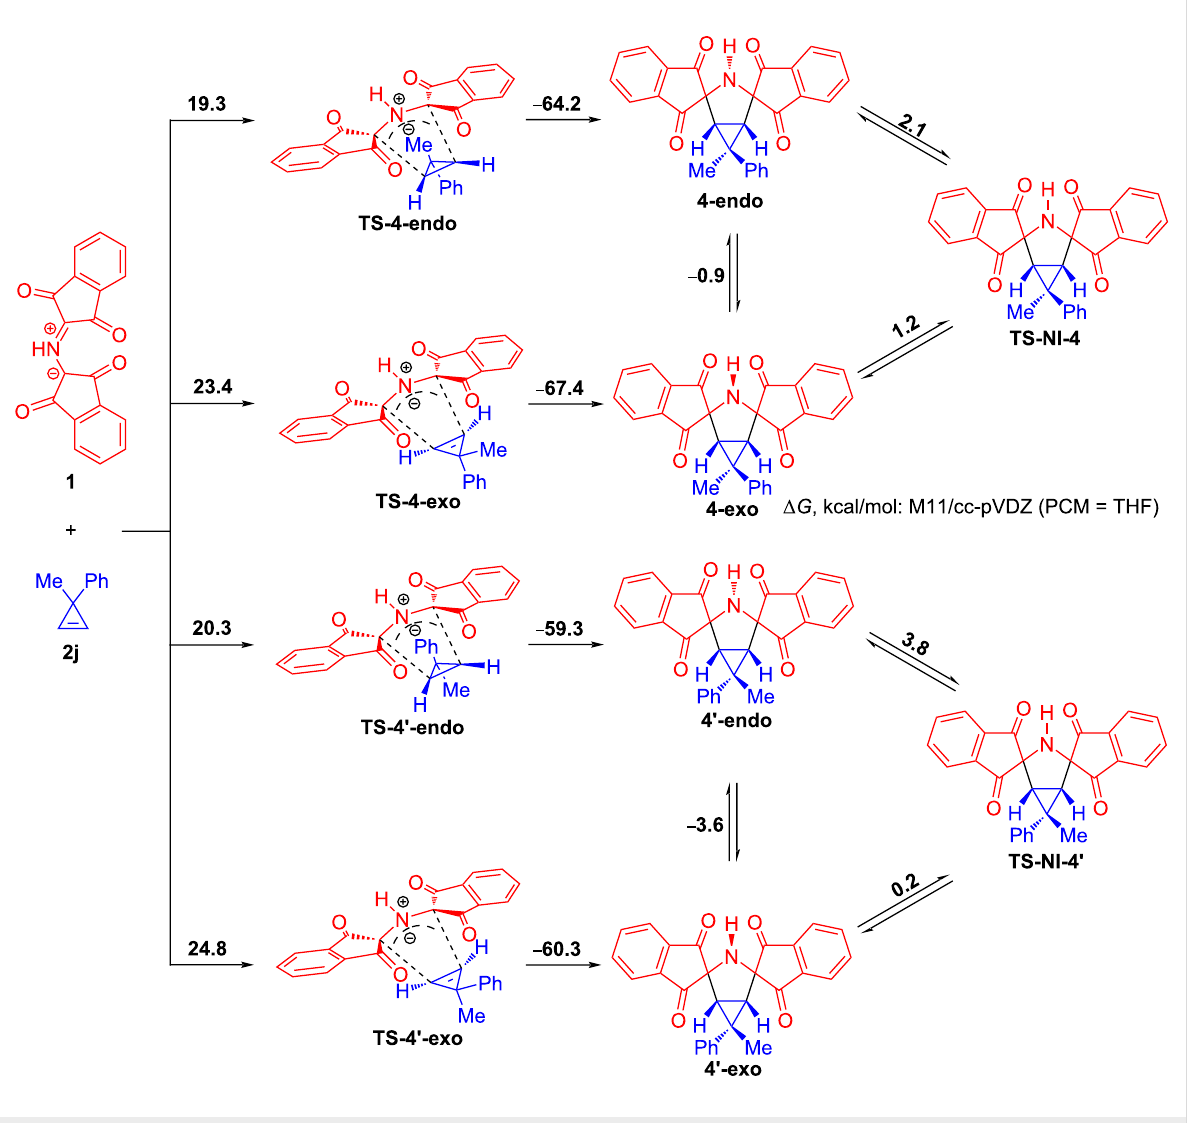
free energy difference (1.0 kcal/mol) between the two competing pathways is in good agreement with the experimen- tal data and explains the reason why the cycloaddition reaction does not result in the exclusive formation of 4